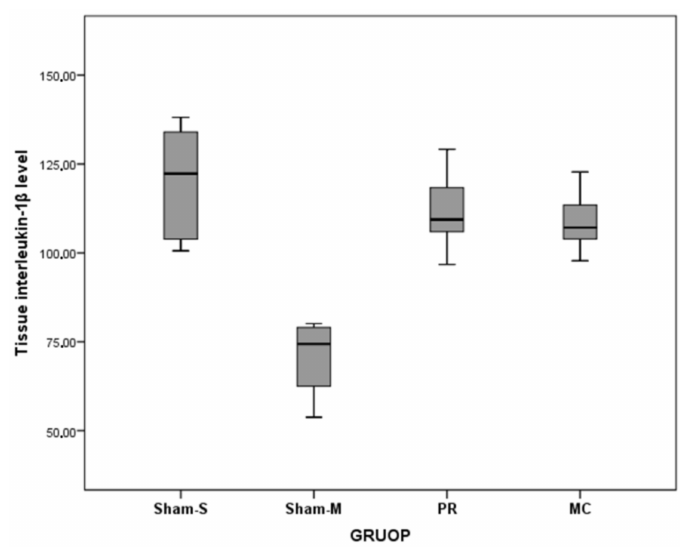
Figure 6. Tissue interleukin-1 β level values of all groups.